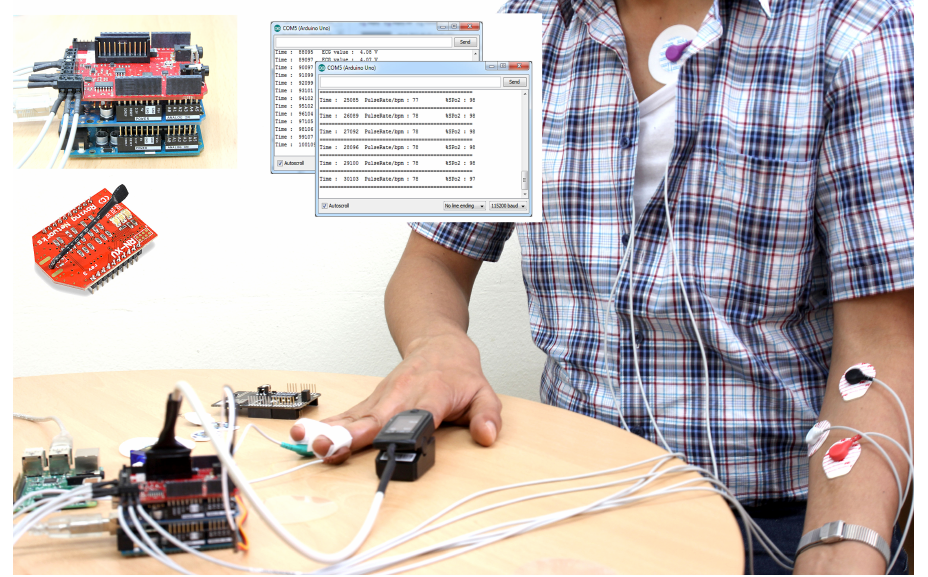
Figure 15. Experimental